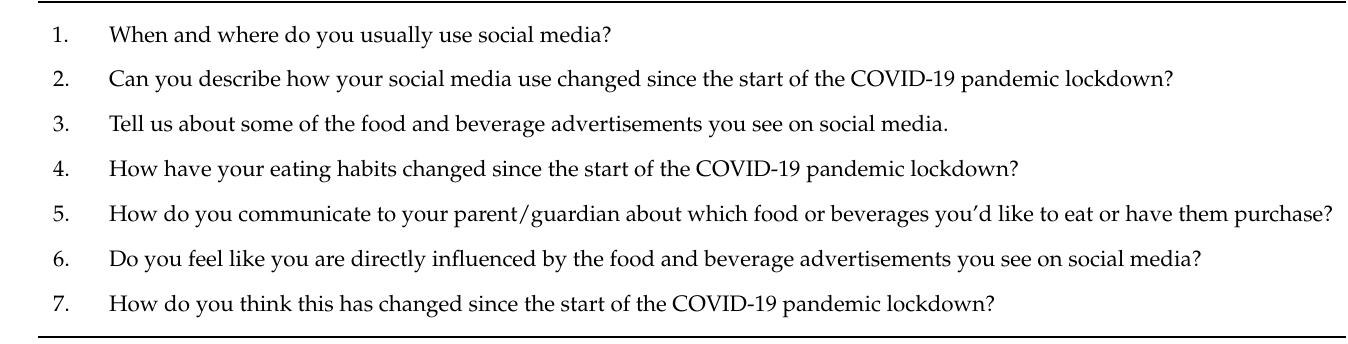
Table 1. Example Questions from Semi-structured Group Interview Guide for